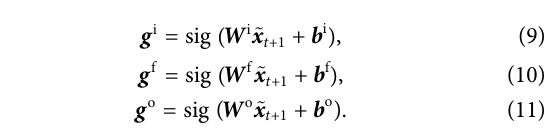
FIGURE1| Visualization ofarecurrent cell. Therecurrent cellconsists of two feedforward layers (light violet squares). A time-delayed recursion (black square) loops the activation of the fi rst or last layer back as additional input to the cell.